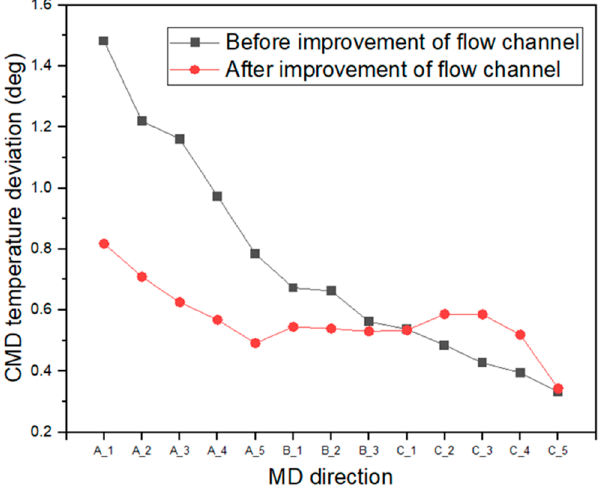
Figure 10. ( a ) Temperature distribution of the web in the dryer and ( b ) effect of flow channel improvements on the temperature distribution of the web.